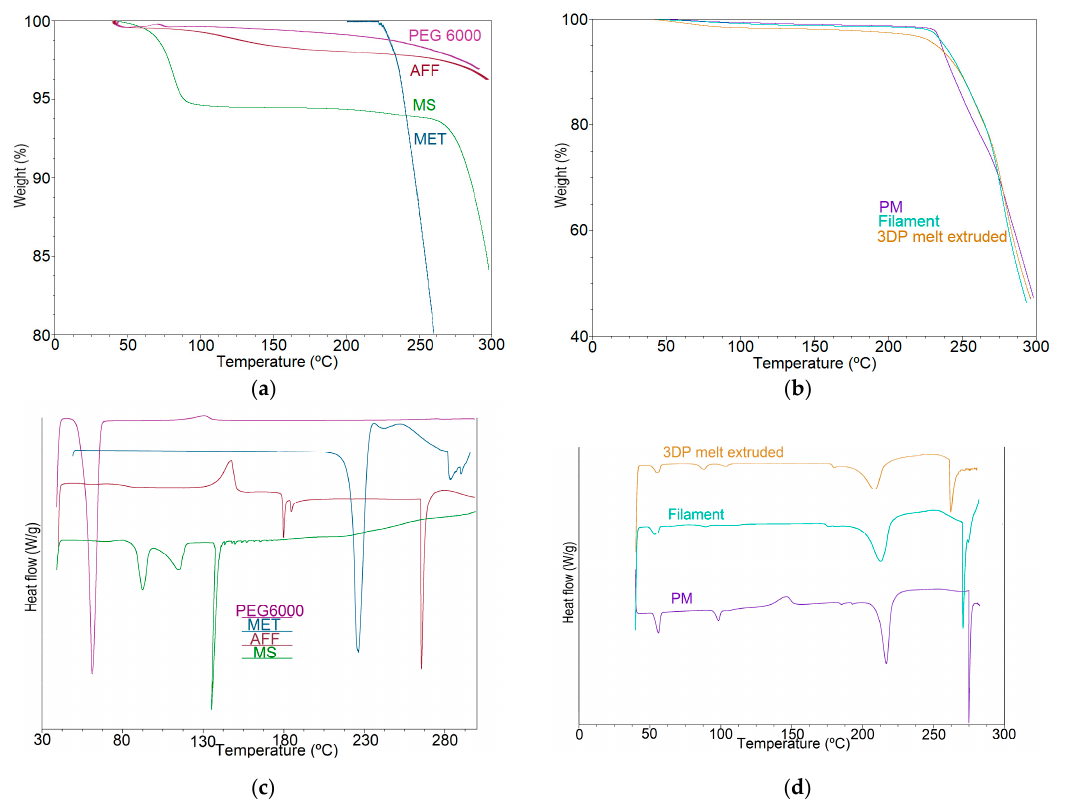
Figure 3. TGA of ( a ) the pure materials and ( b ) the 40B physical mixture, the 40B extruded filament and the 40B 3DP tablet; DSC thermograms of ( c ) the raw materials and ( d ) the 40B physical mixture, the 40B extruded filament and the 40B 3DP tablet.